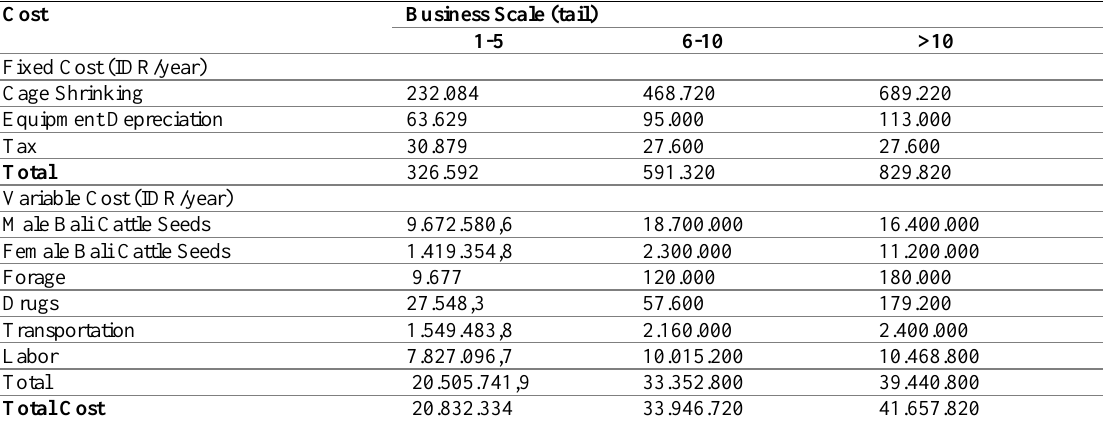
Table 2: Production Cost Structure of Bali Cattle Business with Different Business Scale